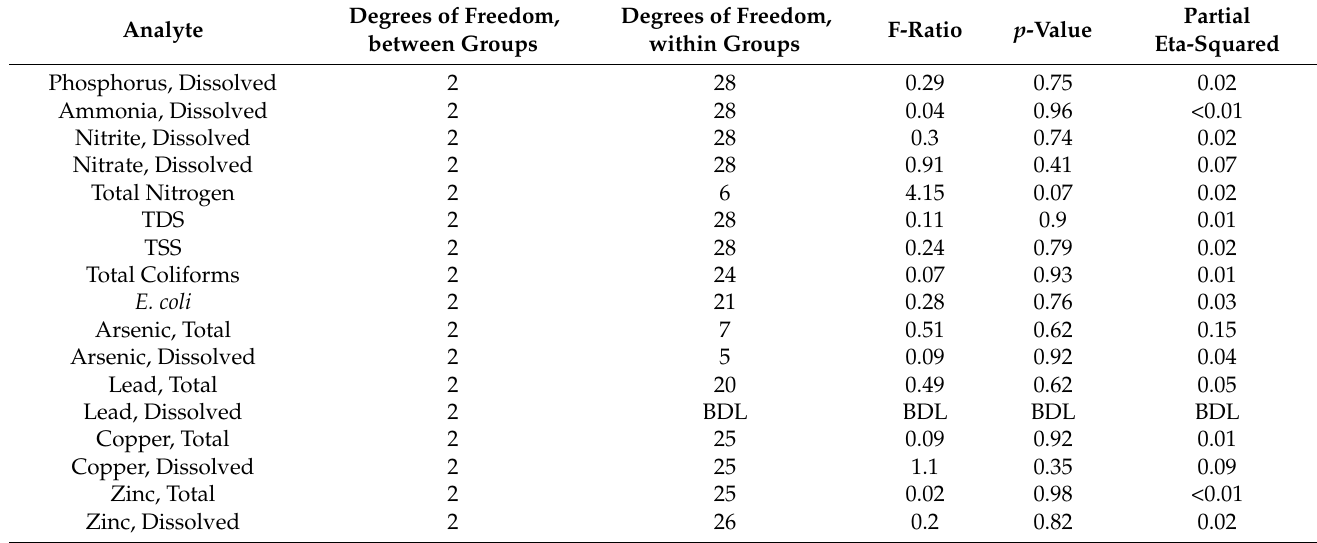
Table A4. ANCOVA results with antecedent dry days as the confounding variable. Degrees of Freedom, Degrees of Freedom, Analyte between Groups within Groups